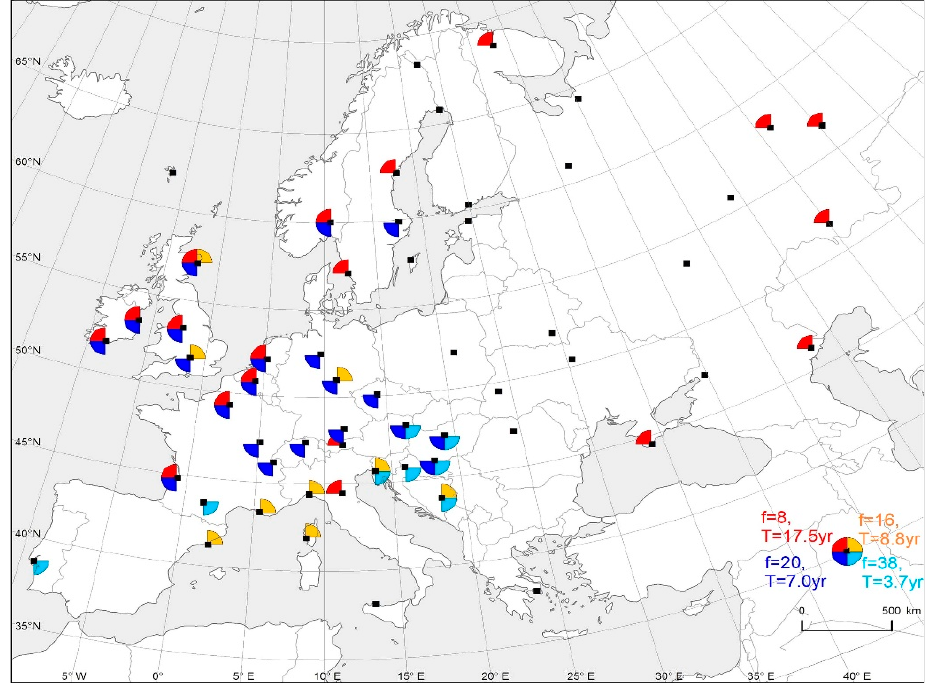
Figure 8. With four colours for different quarters, four frequencies are marked if present at the station: red and yellow for f = 8 and f = 16, respectively, and dark and light blue for f = 20 and f = 38, respectively (periods are, respectively: T = 17.5 years, 8.8 years, 7.0 years, and 3.7 years). Two pairs of harmonically connected frequencies (f = 8 and 16; and f = 20 and 38 ≈ 40) are indicated if present at a given site. The result is negative; harmonics are generally at other sites than its respective main frequency. However, some spatial uniformity of frequency distribution is visible.